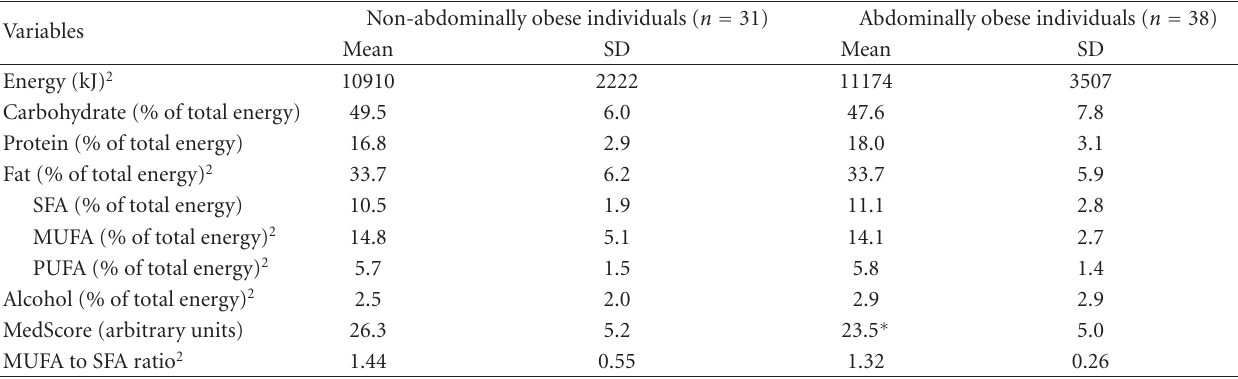
Table 4: Dietary intakes of subjects before the 4-week controlled Mediterranean diet intervention 1